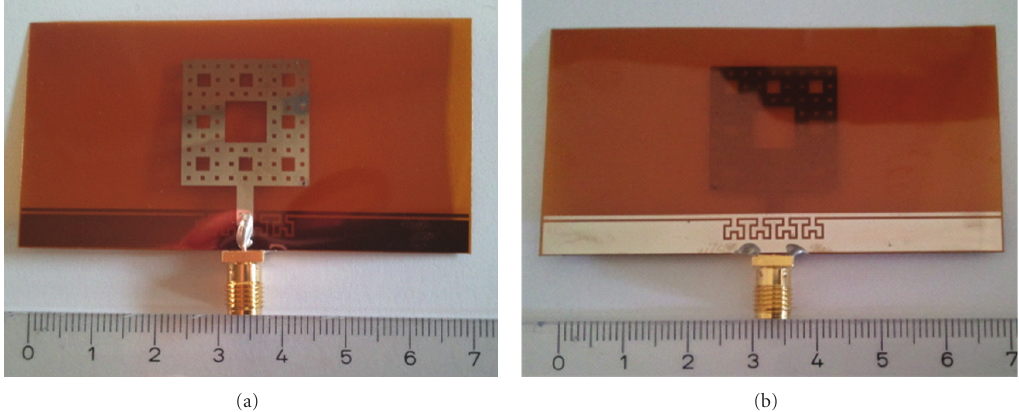
Figure 6: Photographs of the fabricated fractal antenna: (a) top layer, (b) bottom layer.